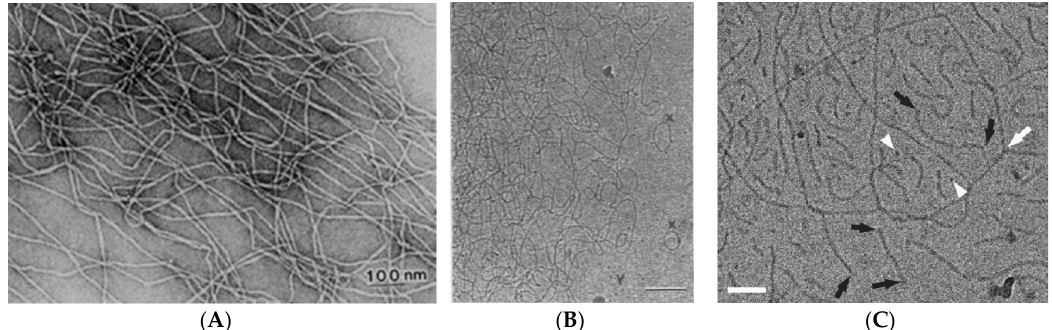
Figure 1. Electron micrograph of ( A ) a sample of 1 mM CTAB/1 mM NaSal [24] (With permission of Springer); ( B ) 50 mM CTAC/50 mM NaSal in 100 mM NaCl (scale bar: 100 nm) [27]; ( C ) NaOleate solution containing 15 wt % octyltrimethyl ammonium bromide (OTAB) (scale bar: 50 nm), white arrows indicate branching points and black arrows the end-caps [25].